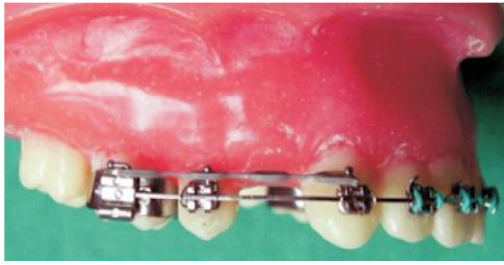
Figure (2): Using of elastic chain for canine retraction